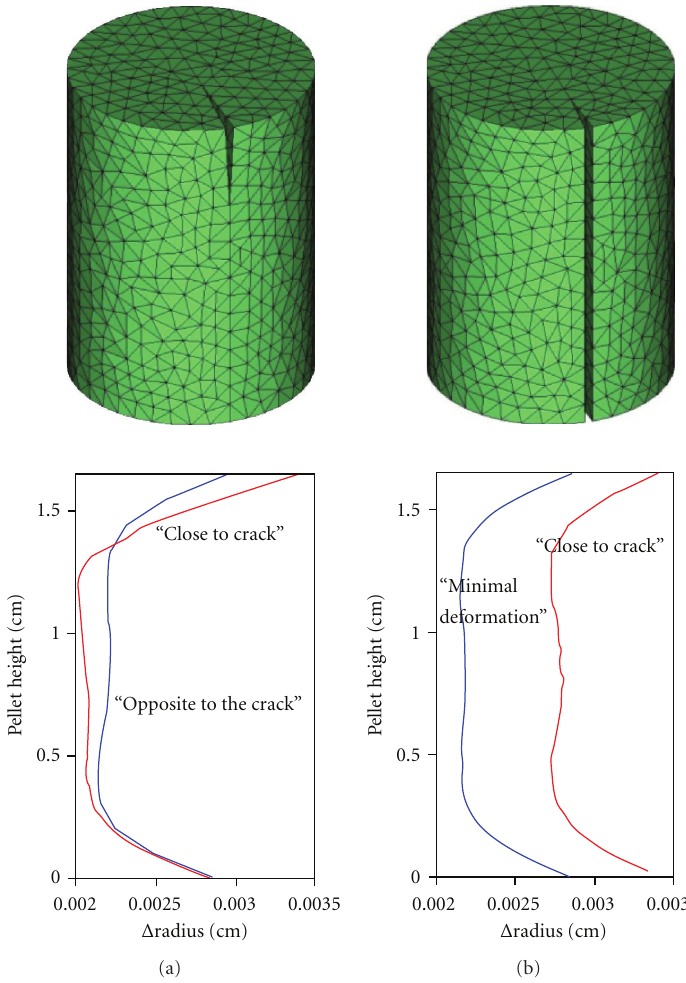
Figure 11: Two types of cracked fuel for stress analysis and its radial profile. (a) Oblique crack. (c) Full vertical crack.